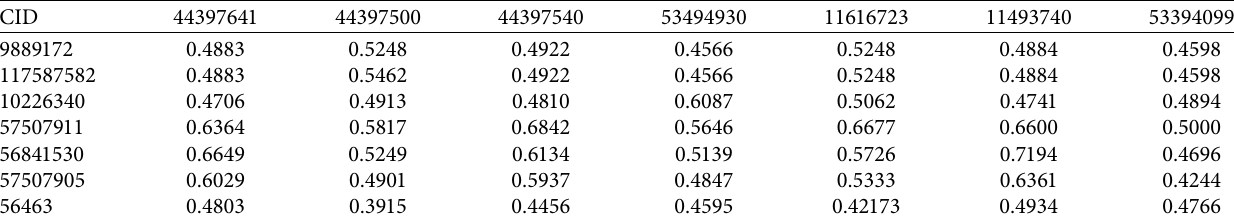
Table 6: Pair-atoms similarities for molecules from different groups.